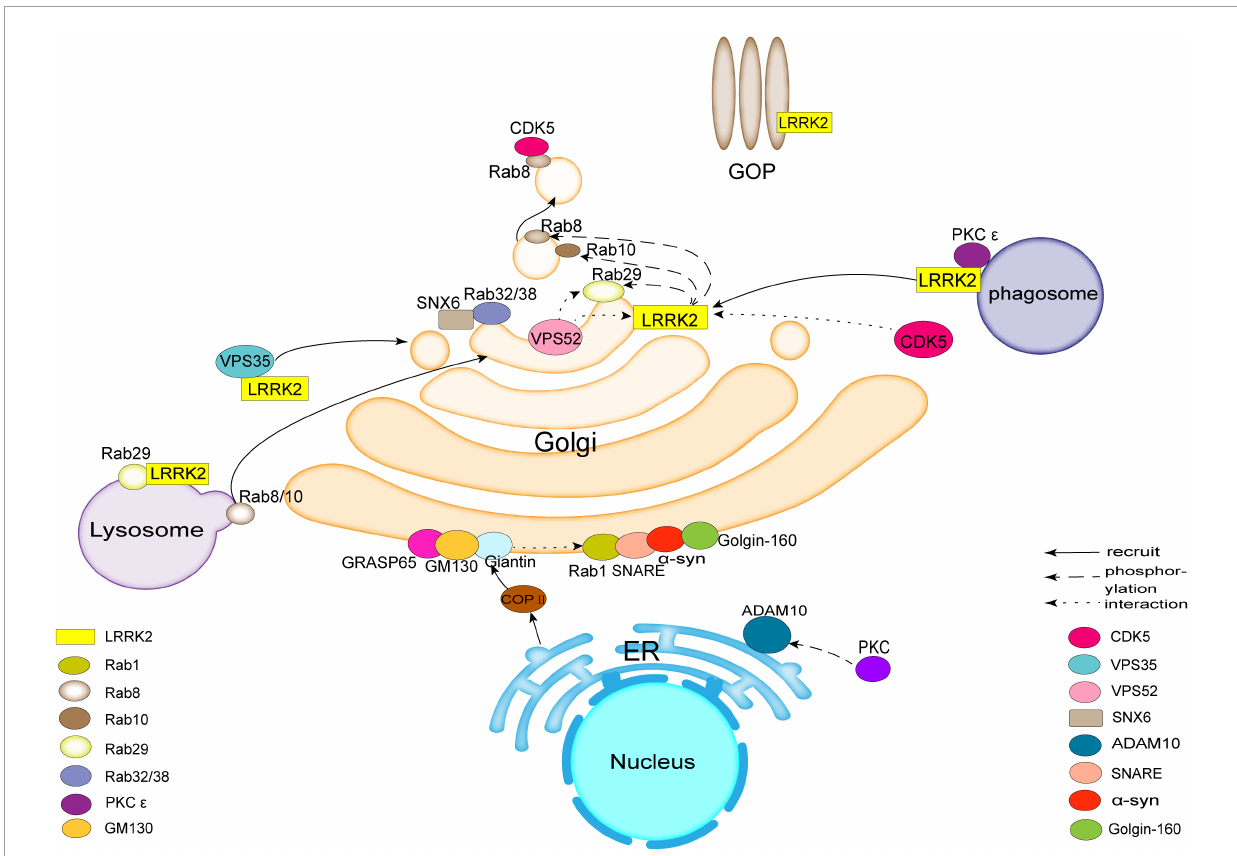
FIGURE1 Leucine-rich repeat kinase 2 (LRRK2) acts as a hub to bind to molecules such as Rab family proteins, Vacuolar protein sorting protein (VPS), Golgi outposts (GOPs), Cyclin-dependent kinase 5 (CDK5), protein kinase C (PKC), synapse-associated protein 97 (SAP97), etc., affecting trans-Golgi network (TGN) membrane transport or Golgi morphology and ultimately inducing pathological features associated with Parkinson’s disease (PD). There are also molecules in the Golgi apparatus (GA), such as Golgin-160, Golgi matrix protein 130 (GM130), syntaxin 5, and others involved in related